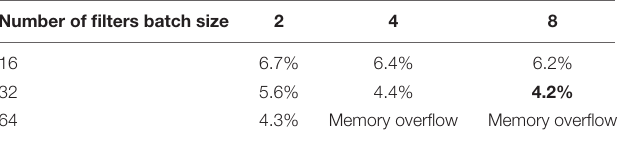
TABLE 1 | Hyperparameter grid